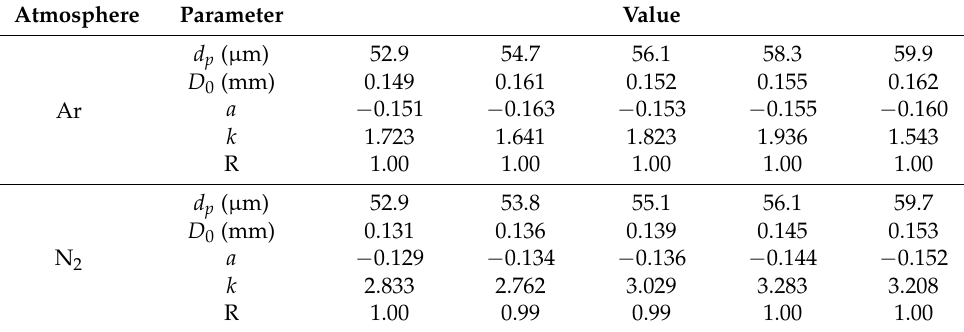
Table 1. The fitting coefficients and correlation coefficients in Equation (5).